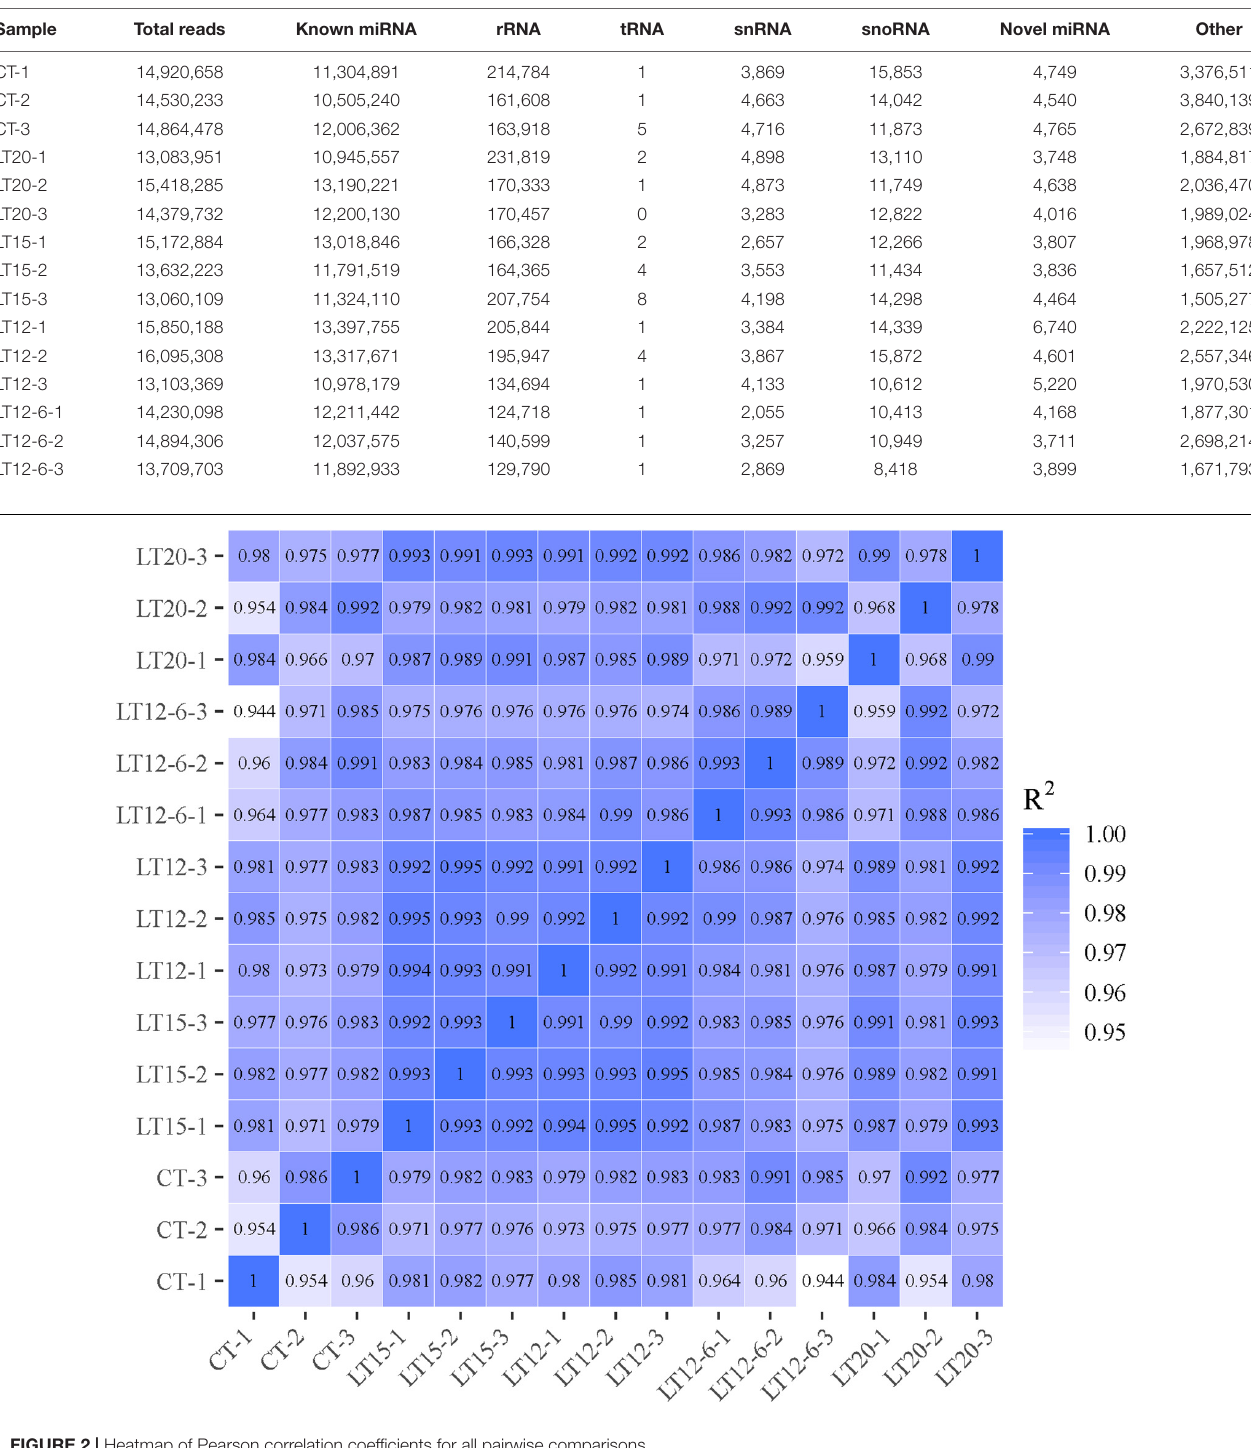
FIGURE 2 | Heatmap of Pearson correlation coefficients for all pairwise comparisons.